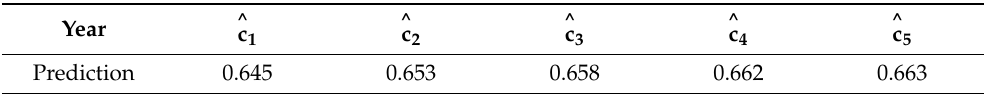
Table 22. Forecasting the coupon rate for T = 1,2,3,4,5.